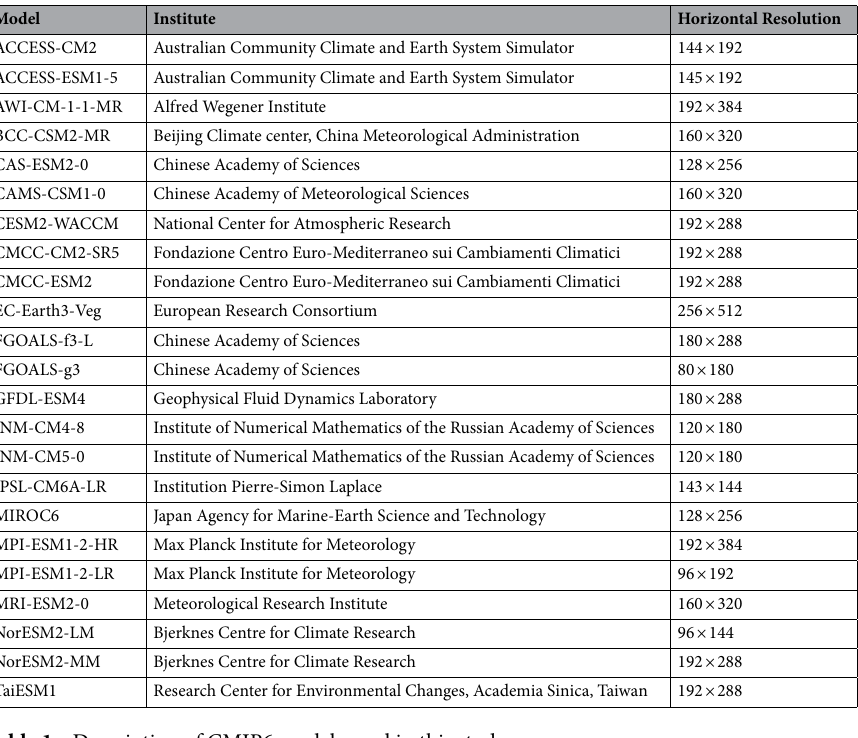
Table 1. Description of CMIP6 models used in this